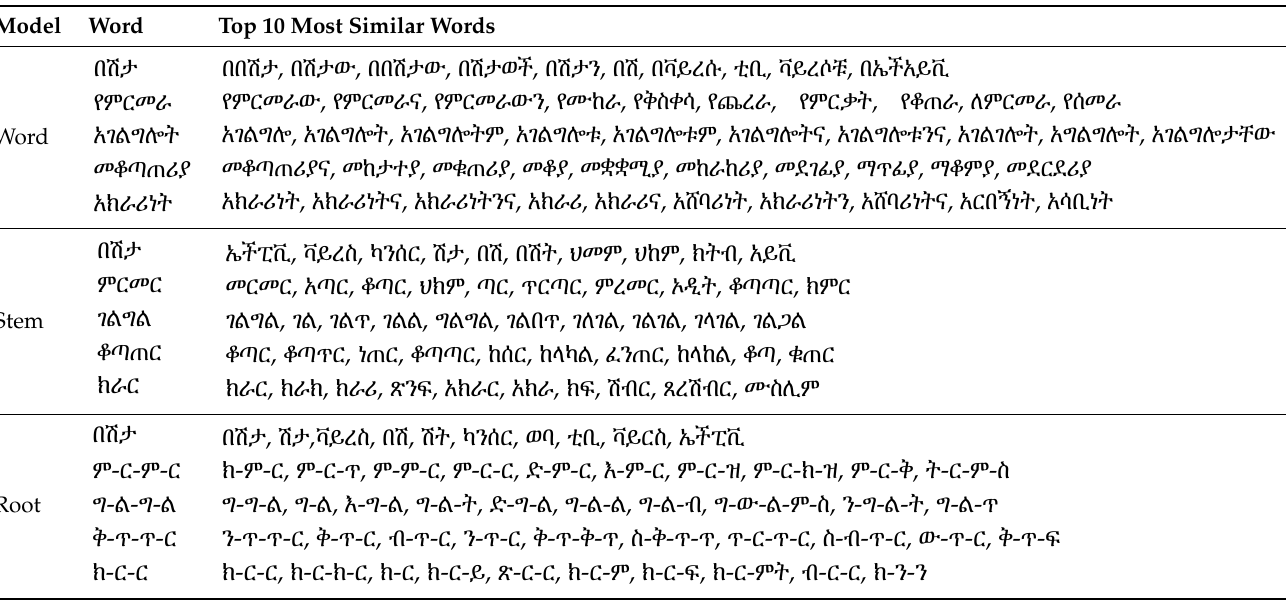
Table 11. Top four expanded terms of the query word አቅርቦትና / ʔəkʼirɨbotɨna /. Roots of verbs are rep- resented by consonant separated by hyphen (-).